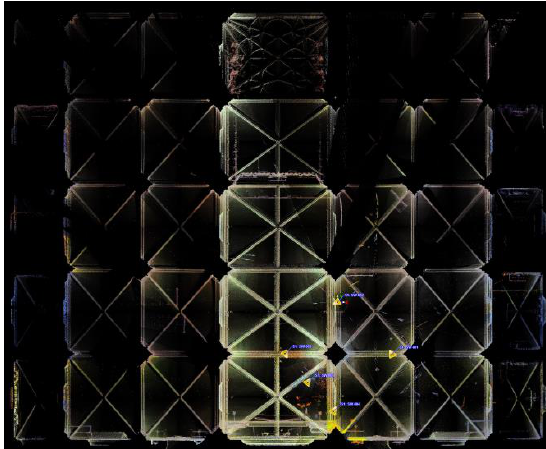
Figure 3. Top view of the ceiling in the Cathedral of Seville, taken using